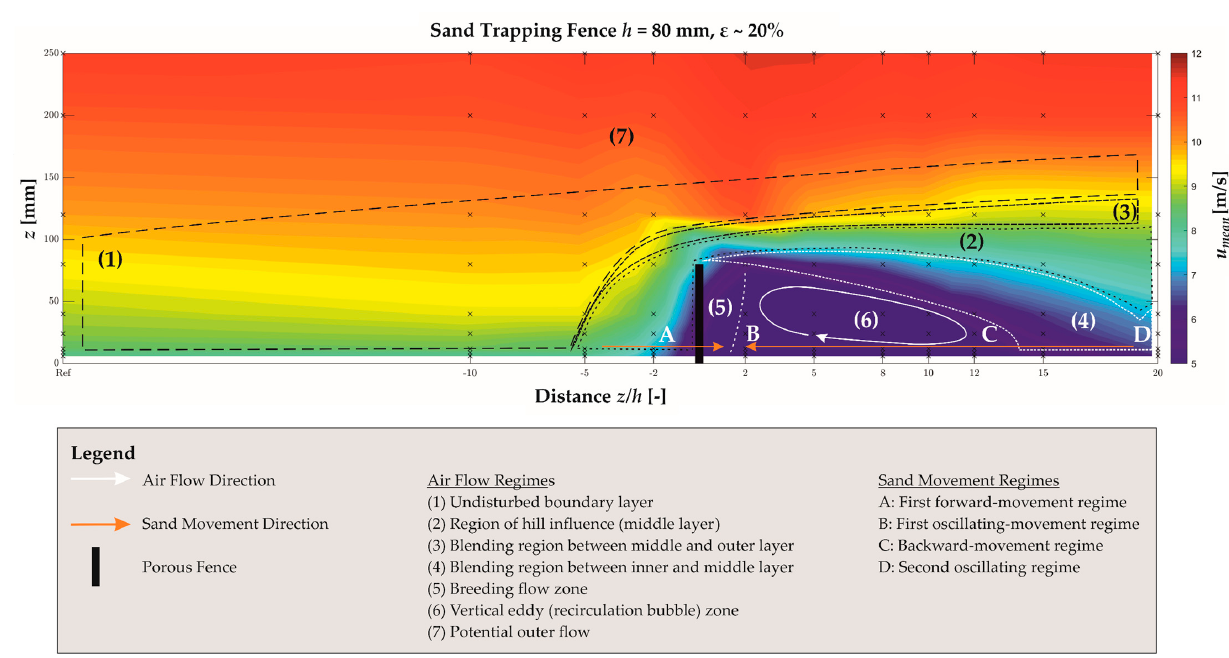
Figure 4. Typical regimes of airflow and sand movement over a single porous fence from laboratory experiments (adapted from [17,46,48]).